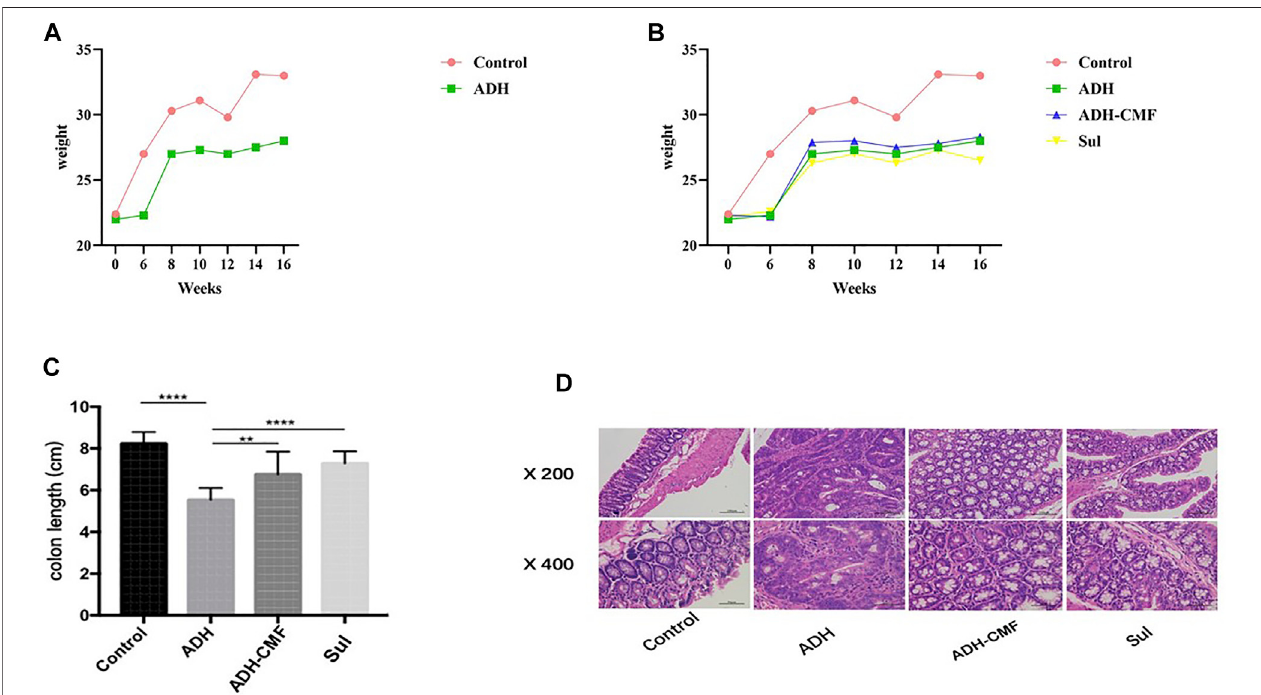
FIGURE1| Effect ofCMF on morphologicalchangesofintestinal Adenomainmice. (A) bodyweightofmice in Control groupand ADH group; (B) Changeofbody weightofmiceineachgroup. (C) Statisticalanalysisofcoloniclengthineachgroupofmice;**** p < 0.001;** p < 0.01; (D) ResultsofHEstainingincolonictissuesofeach